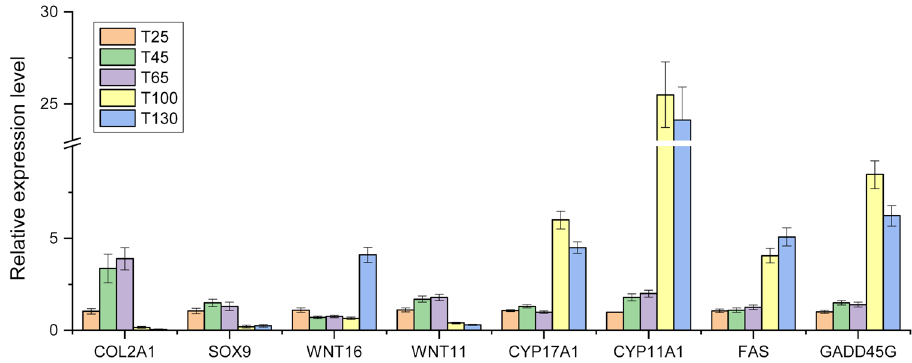
Figure 6. The relative expression levels of 8 genes by qRT-PCR. The figure was generated by OriginPro 2018 software (b9.5.0.193, https:// www. origi nlab.